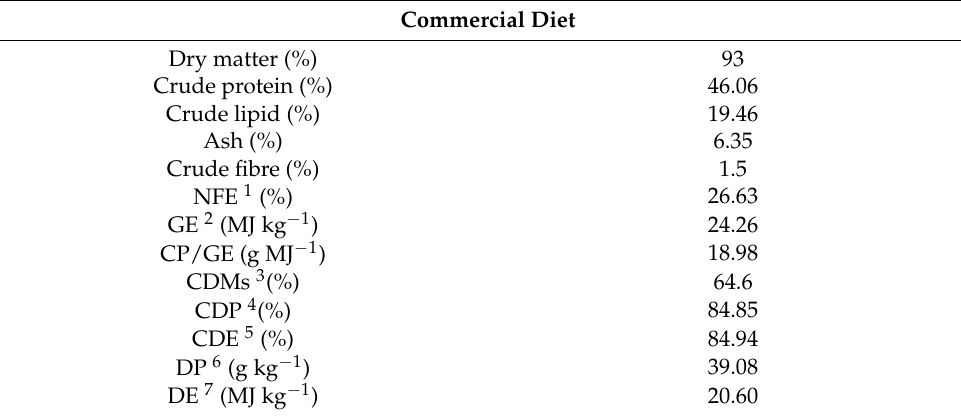
Table 2. Diet composition and proximate